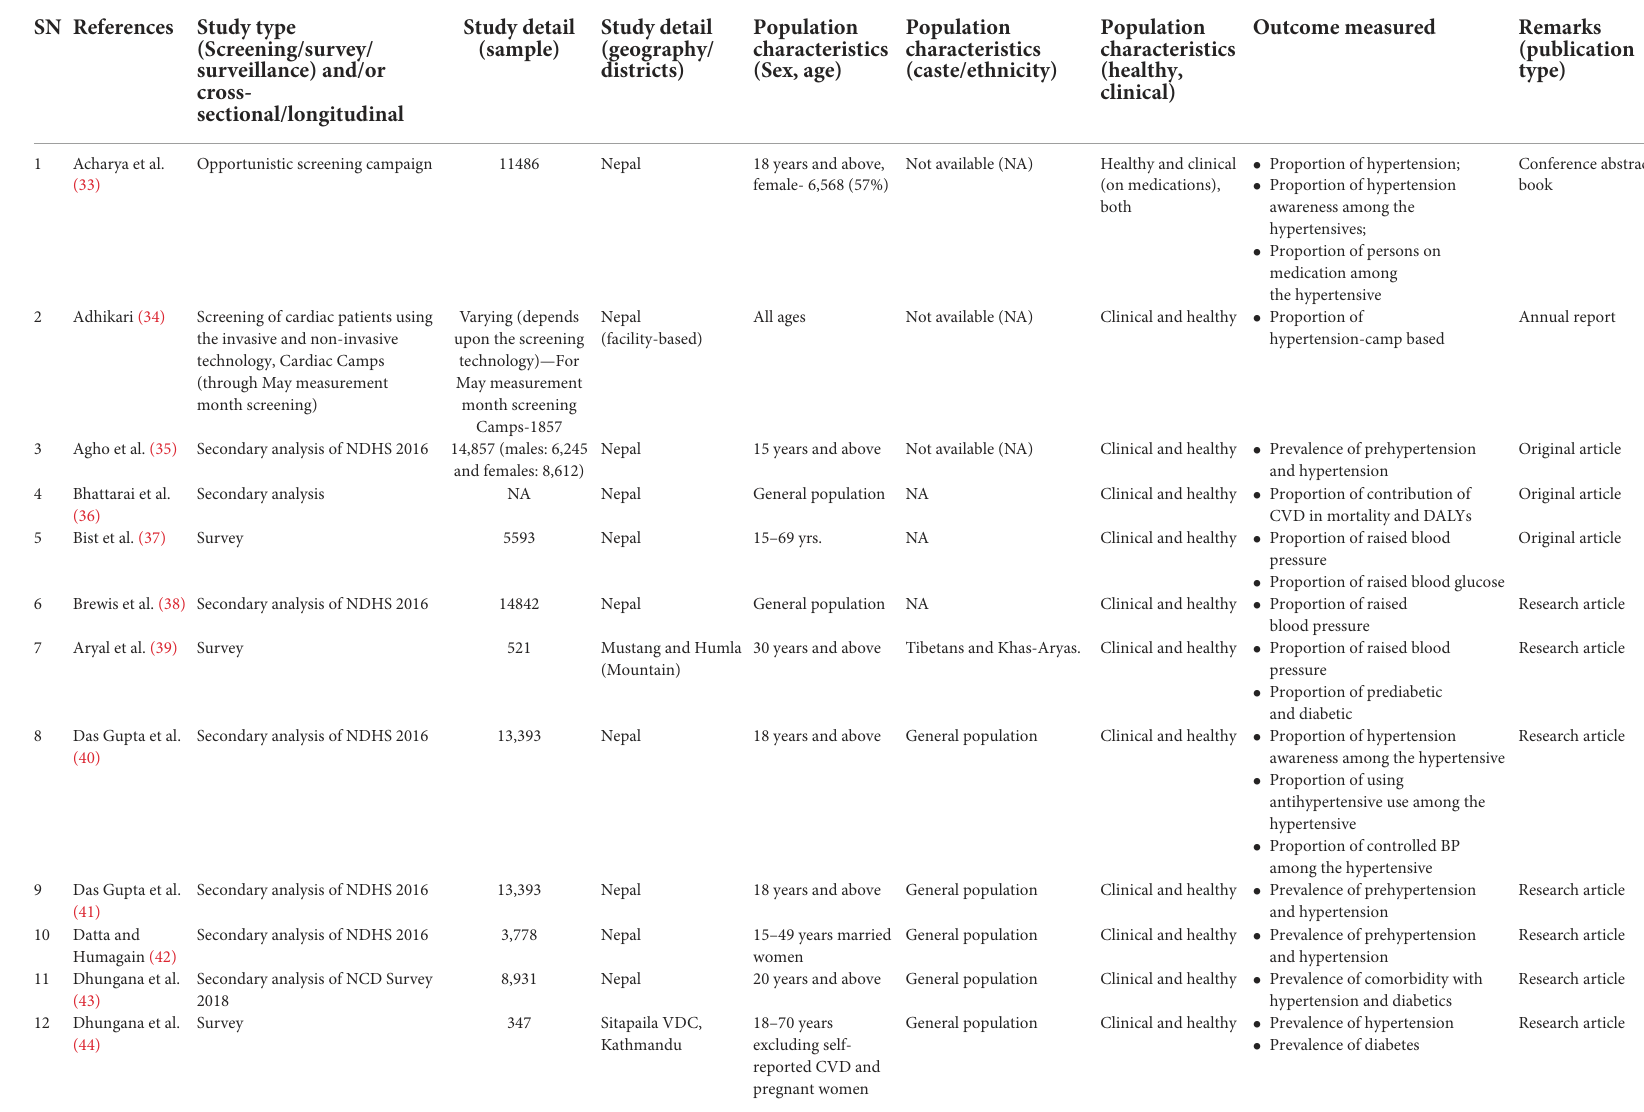
TABLE 2 Characteristics of the included